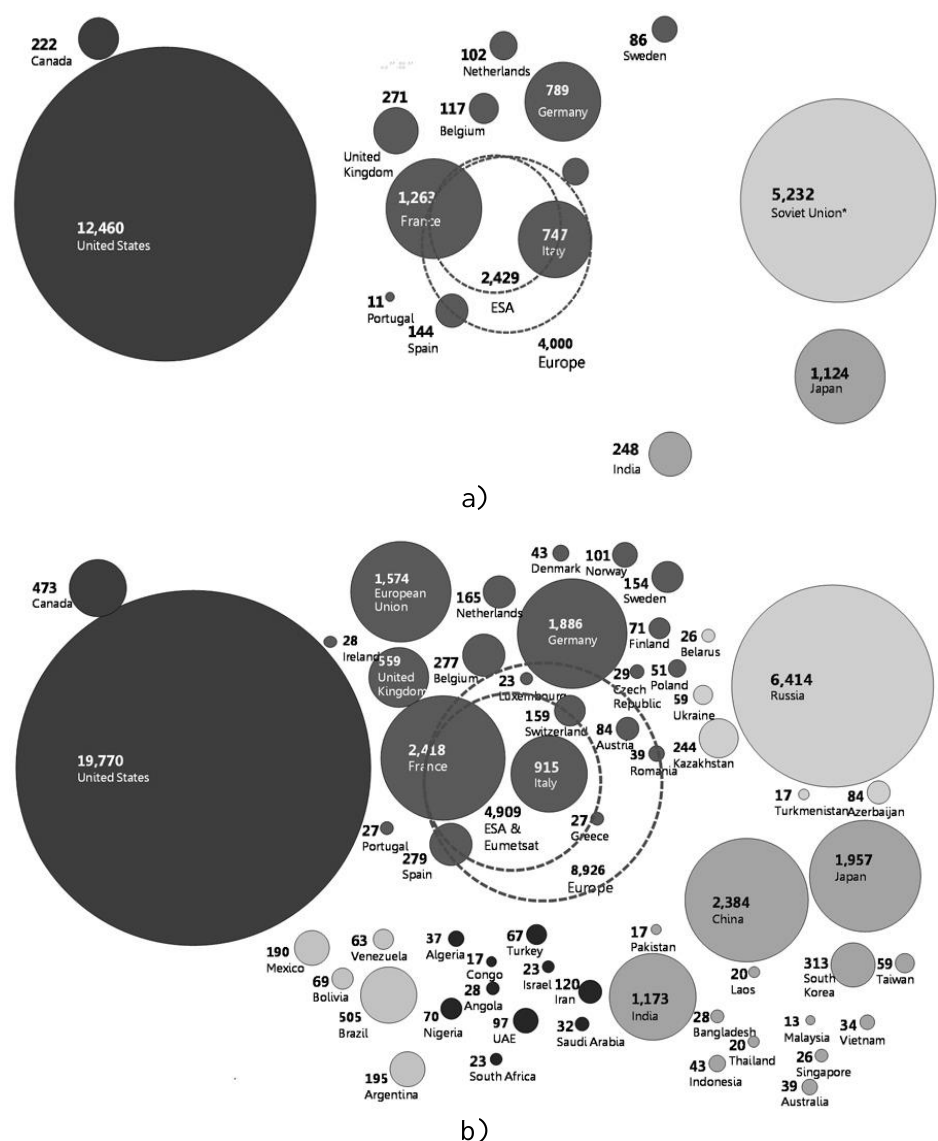
Fig. 2. Government expenditures for space programmes, 1990 and 2013 (only the countries spending over $10 million): a) 15 countries in 1990; b) 58 countries in 2013 (Euroconsult,